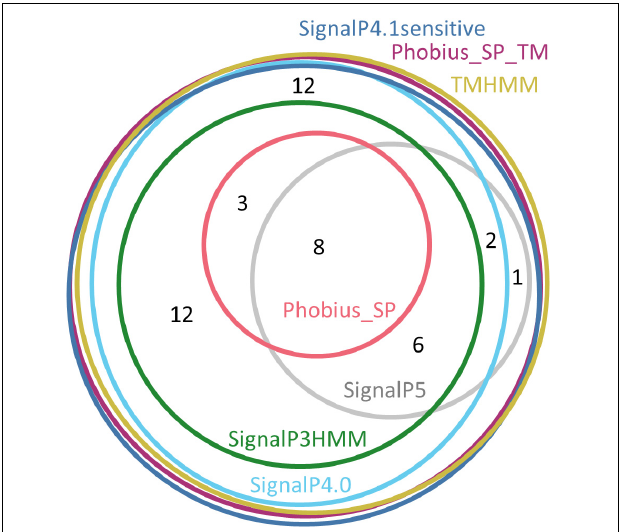
FIGURE 4 | Euler diagram representing the overlap of positive signal peptide predictions for pooled sequences from the AYWB_387, AYWB_376, and AYWB_042 families. The numbers indicate counts of